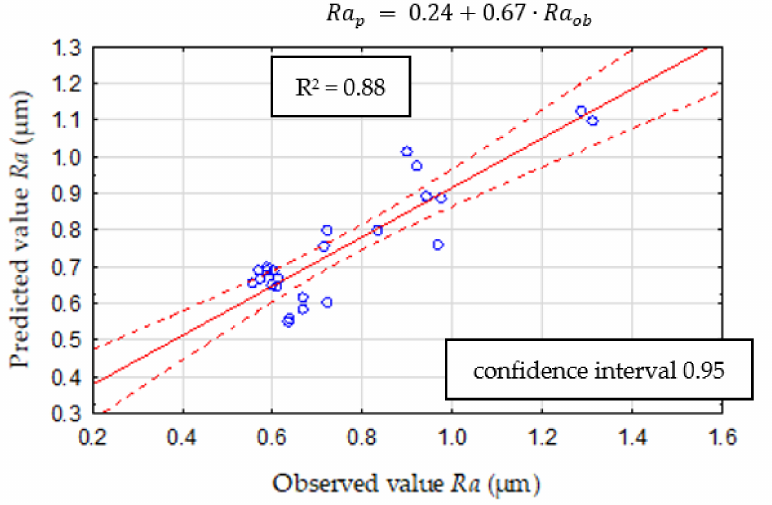
Figure 17. ANN validation